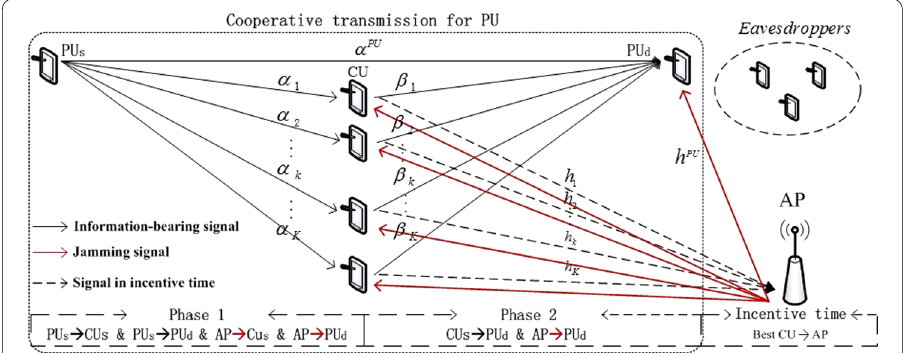
Fig. 1 System architecture for coexistence of primary and cognitive networks with privacy